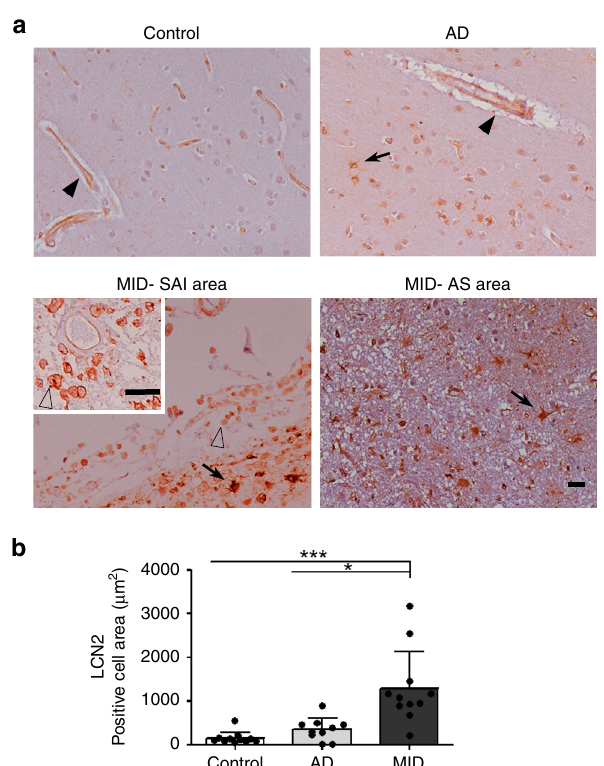
Fig. 4 LCN2 expression in control, AD, and MID brain tissue. a LCN2 immunohistochemistry in the cerebral cortex of control, Alzheimer ’ s disease (AD), and Multi-Infarct Chronic Encephalopathy (MID) cases, including subacute infarct areas (MID-SAI area) and astrocytic scar areas (MID-AS area). LCN2 staining is observed in intact blood vessels in controls, AD and MID cases (arrow-heads). Increased LCN2 expression is observed in reactive astrocytes in AD and MID (arrows) and in monocyte/ macrophage cells of the MID-SAI area (empty arrow-heads). Paraf fi n sections counterstained with hematoxylin. Bar: 25 µ m; insert-bar 50 µ m. b Quanti fi cation of LCN2 positive cells area in cerebral cortex and striatum in µ m 2 . Signi fi cant increase of LCN2 positive cells area in MID cases with respect to controls (*** p < 0.001) and AD cases (* p < 0.05). Shown results are means (±SD) of controls ( n = 11), AD ( n = 10), and MID ( n = 11) cases. In MID cases, area of subacute infraction (n = 6) and chronic infarcts ( n = 11) were analysed. Results were analysed by Kruskal-Wallis followed